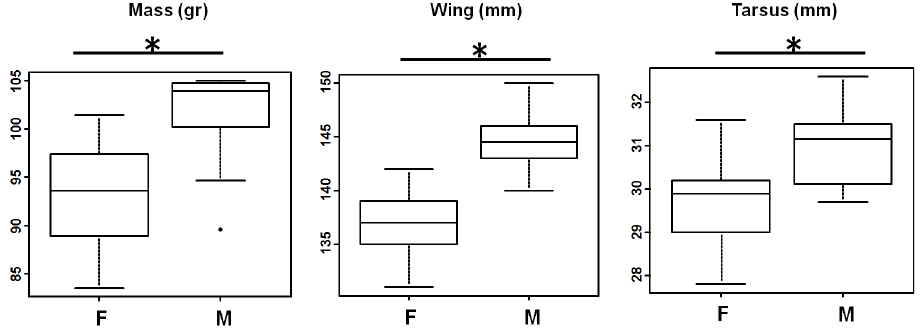
Fig 2. Morphological measurement differences between males and females. Box plots of mass, wing and tarsus data. All data were collected by a single ringer (AC). * : significant difference at p (cid:3) 0.05.